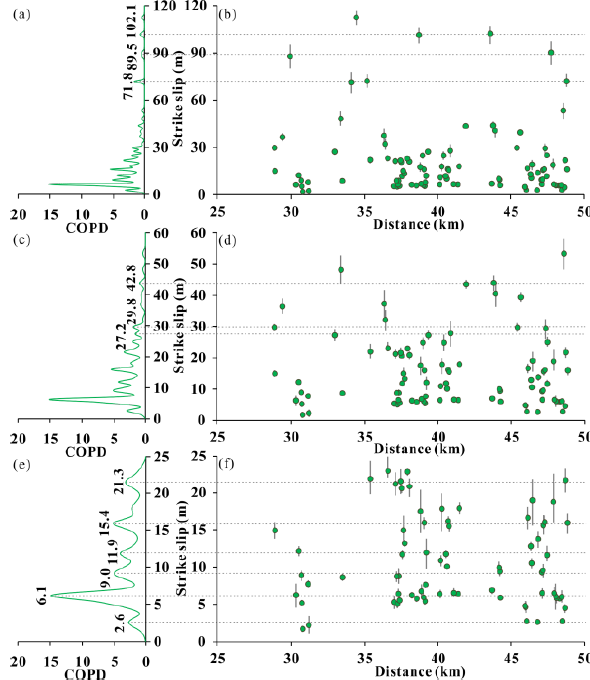
Figure 8. Vertical displacement on the south segment of the West Helanshan Fault. (a), (c), and (e) represent the cumulative offset probability density (COPD) plot of the vertical displacement in the range of 0~80 m, 0~20 m, and 0~8 m respectively. While (b), (d), and (f) denote the distribution of the vertical displacement along the fault strike in the range of 0~80 m, 0~20 m, and 0~8 m